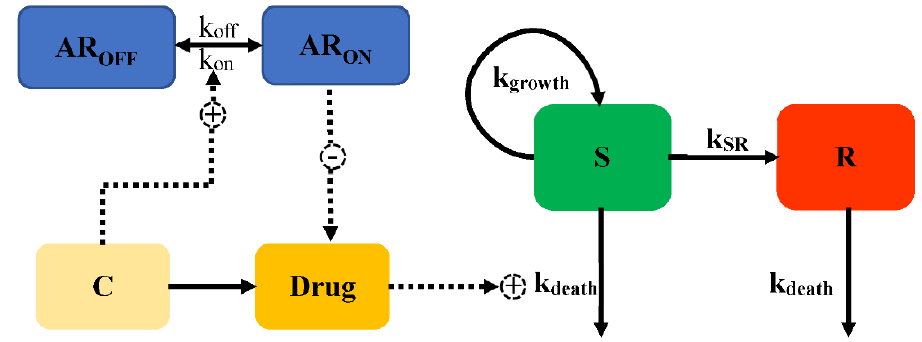
Figure 8. Schematic illustration of adaptive resistance (Model